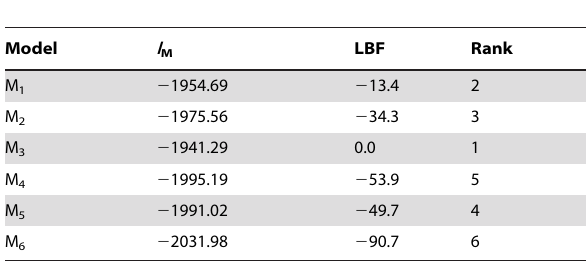
l M : Log marginal likelihood, LBF: Log Bayes factors.